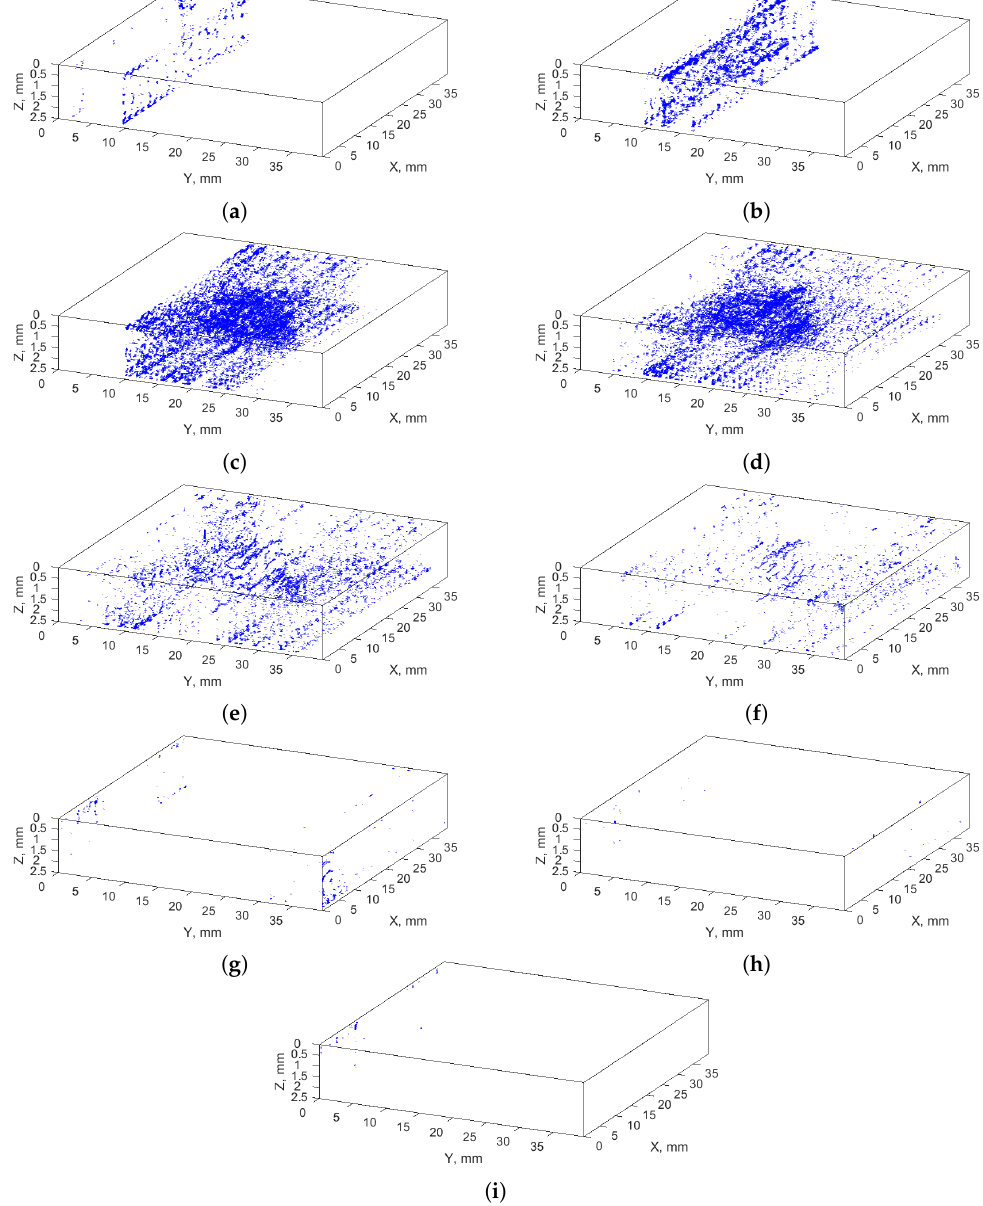
Figure 6. Recognized anomalies—clusters with negative labels nos.: ( a ) − 4; ( b ) − 5; ( c ) − 6; ( d ) − 7; ( e ) − 8; ( f ) − 9; ( g ) − 10; ( h ) − 11; ( i ) −